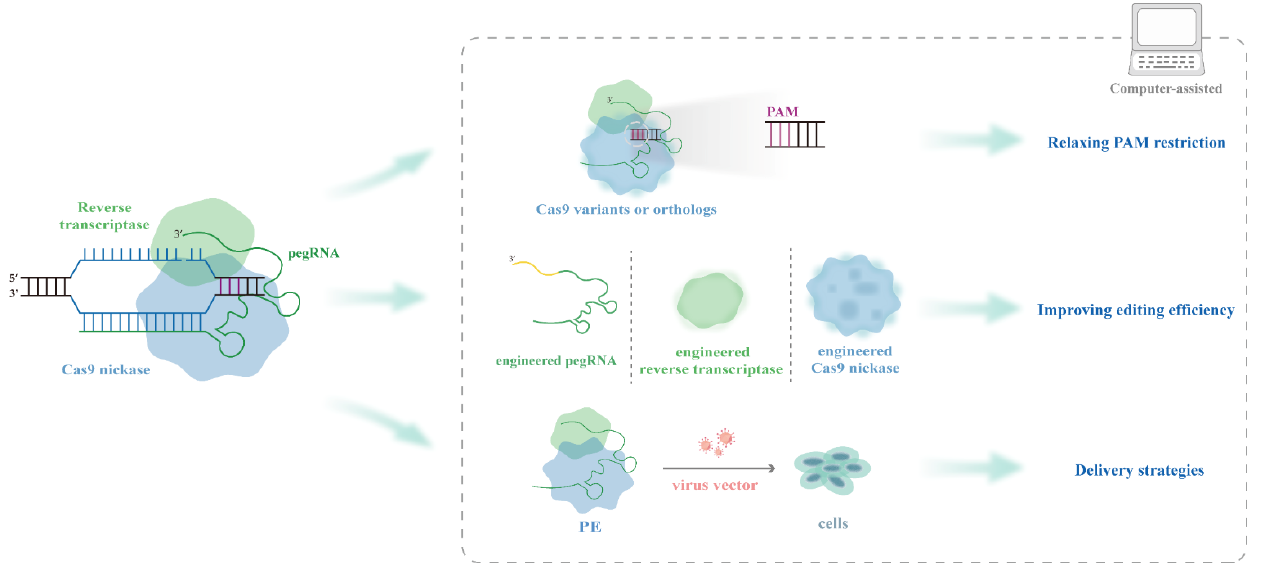
Figure 2. Optimization of PE. Showing the several aspects of optimizing PE and computing assists the development of PE in many